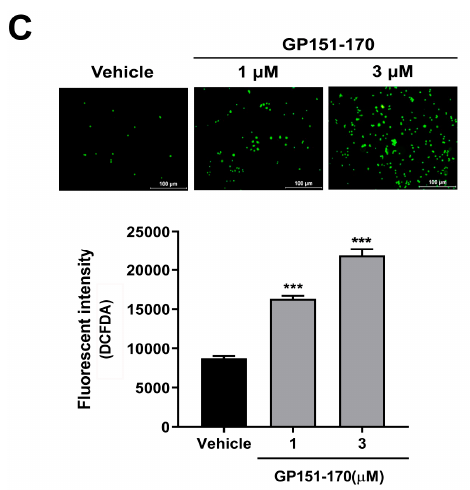
Figure 3. Effects of the synthetic gliadin peptide GP151–170 on reactive oxygen species (ROS) production in mammalian cell cultures. ( A,B ) Cell viability in RAW264.7 macrophages after treatment with either the synthetic gliadin peptide GP110–130 or GP151–170. ( C ) Intracellular ROS levels were evaluated by measuring the intensity of 2 ′ ,7 ′ -dichlorodihydrofluorescein diacetate (DCFDA) fluorescence using a microplate reader. A bar graph showing the pixel intensities of DCFDA fluorescence is shown. Error bars represent s.d. ** p < 0.01. *** p < 0.001 (Student’s t -test). C, control.